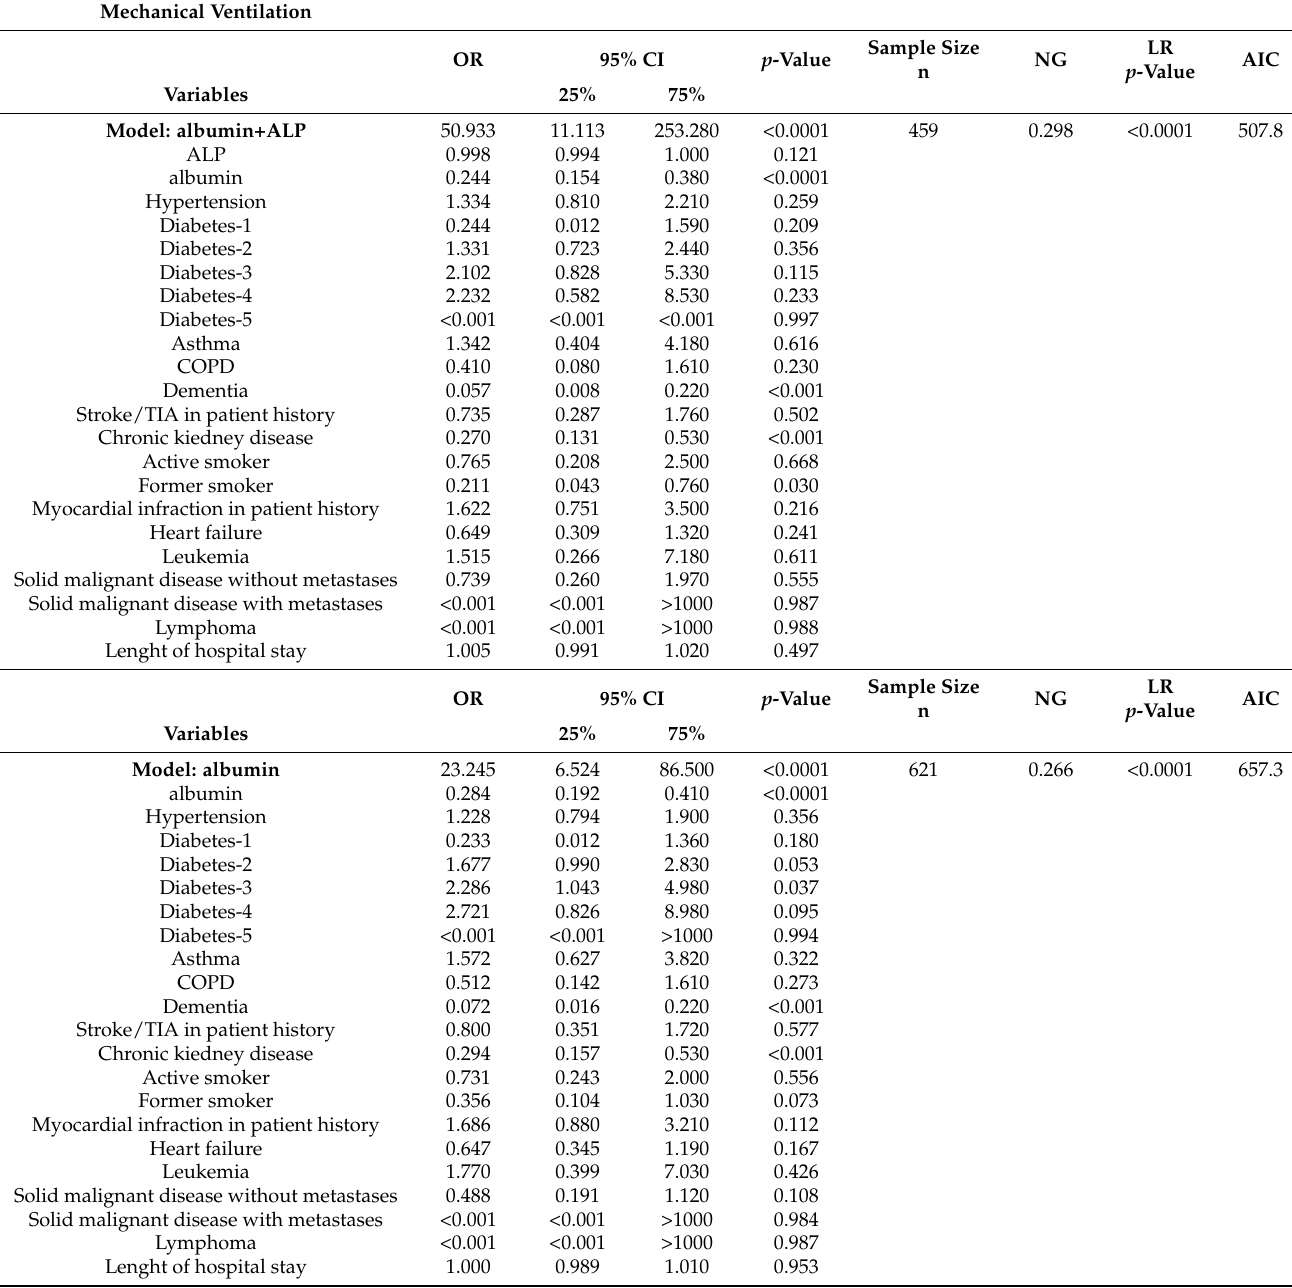
Table 6. The best models to predict nesscesity of mechanical ventilation in COVID-19 tested on larger groups of